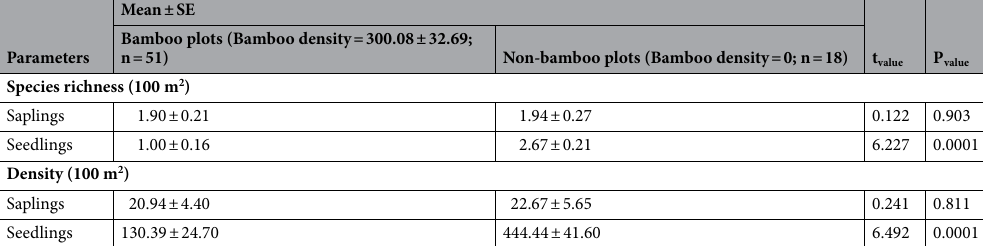
Mean ± SE Bamboo plots (Bamboo density = 300.08 ± 32.69; n = 51) Non-bamboo plots (Bamboo density = 0; n = Parameters